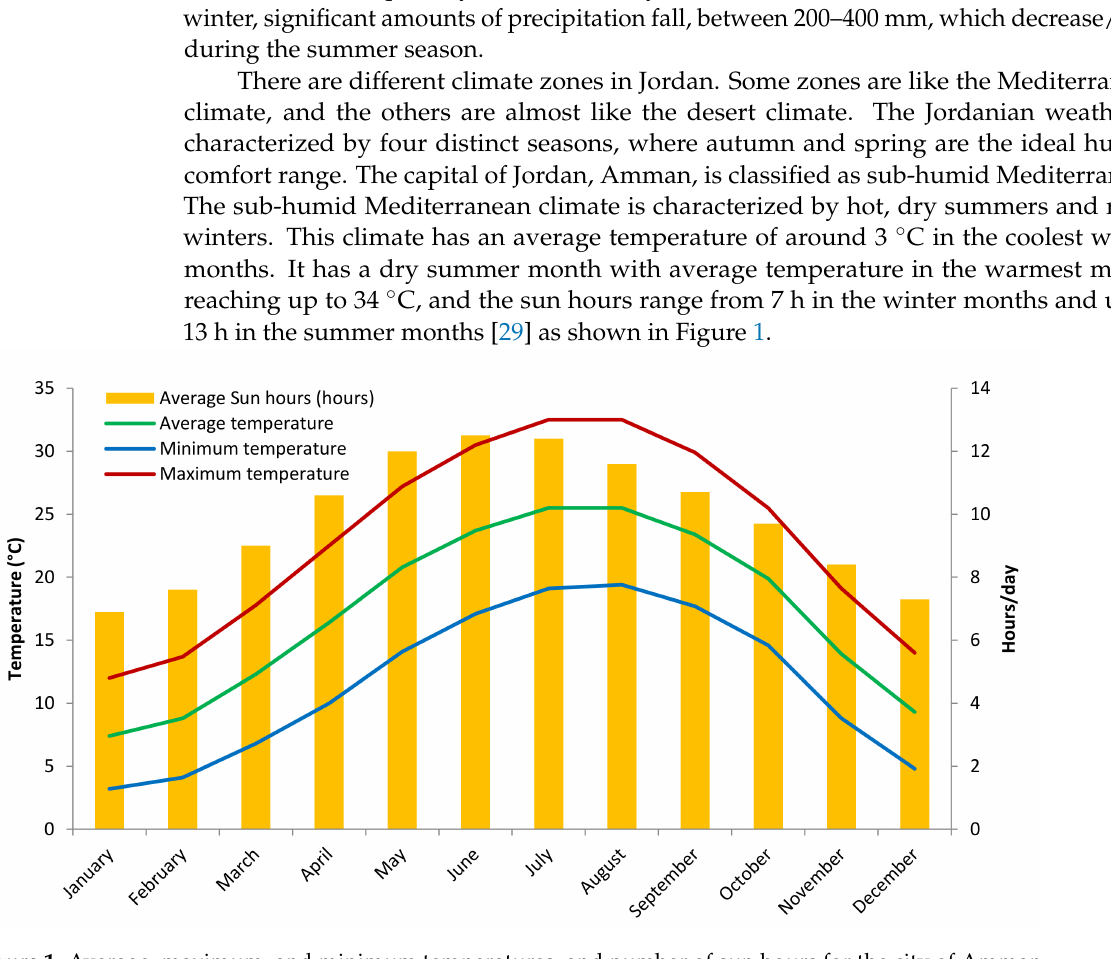
Figure 1. Average, maximum, and minimum temperatures, and number of sun hours for the city of Amman. A house with an area of 130 m 2 , located in Amman, Jordan (31.98 ◦ N latitude; 35.98 ◦